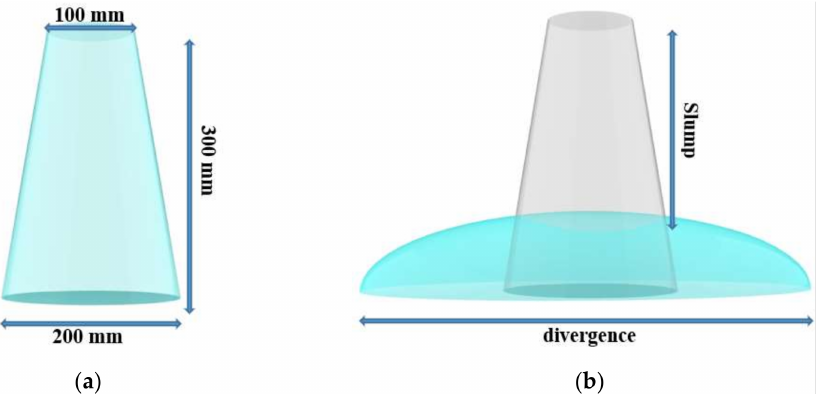
Figure 3. Schematic of slump tests: ( a ) size of the slump cone and ( b ) measurement of slump and